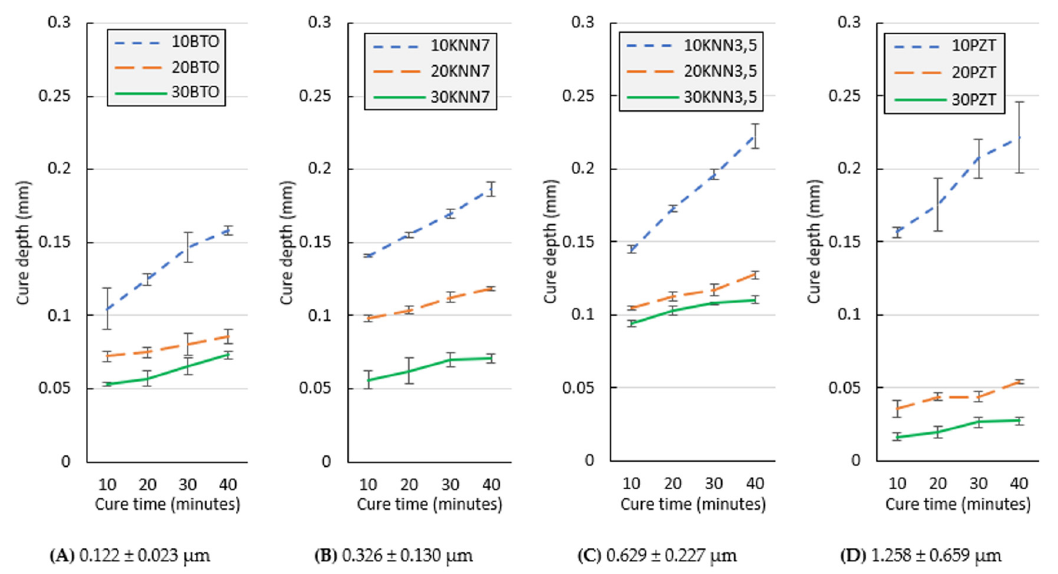
Figure 8. Curing depths of piezoelectric composites made with ( A ) BTO, ( B ) KNN7, ( C ) KNN3.5, or ( D )